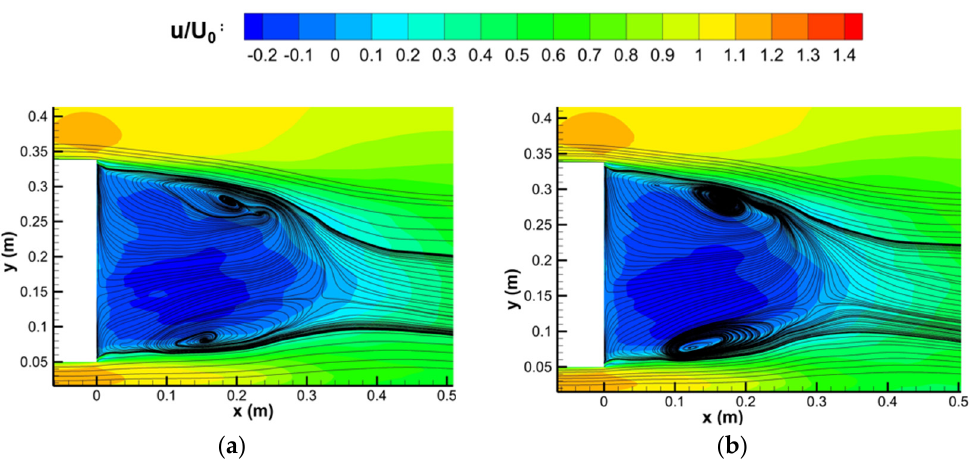
Figure 22. Time-averaged streamlines in the behind of the model, on the symmetry plane with an unsteady jet at different control frequencies. ( a ) f c = 34 Hz; ( b ) f c = 68 Hz; f c = 272 Hz.